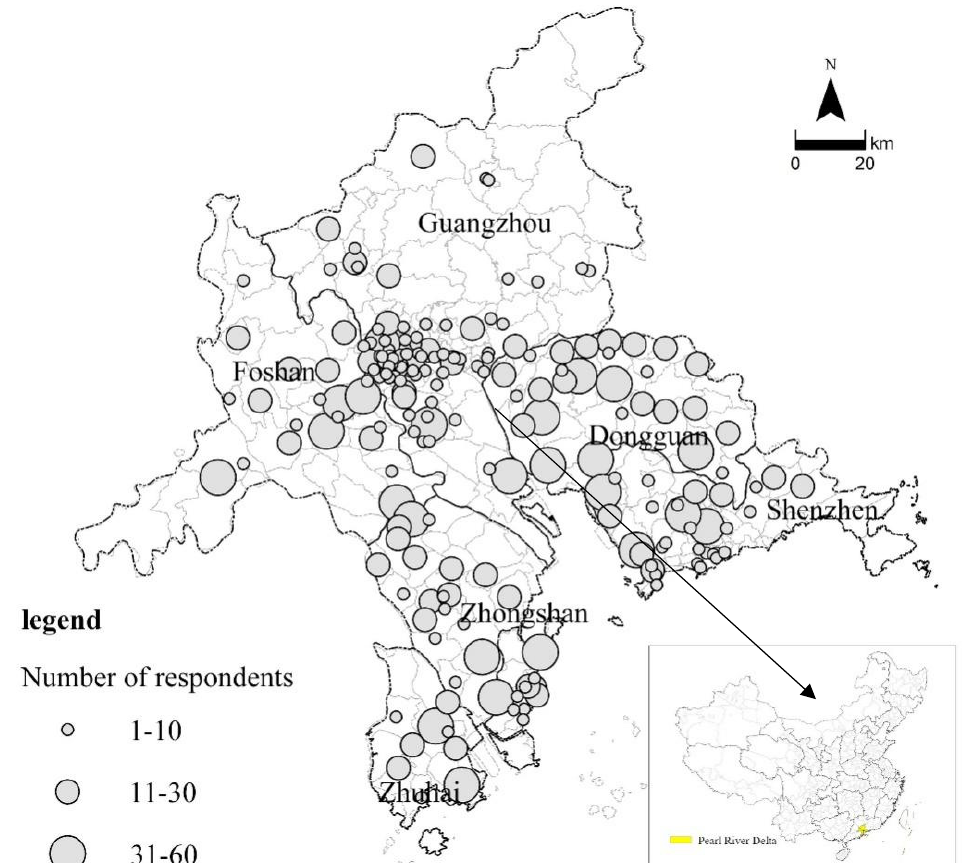
Figure 1. Spatial distribution of respondents.